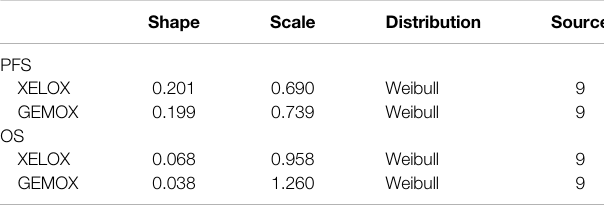
TABLE 1 | Key model parameters.